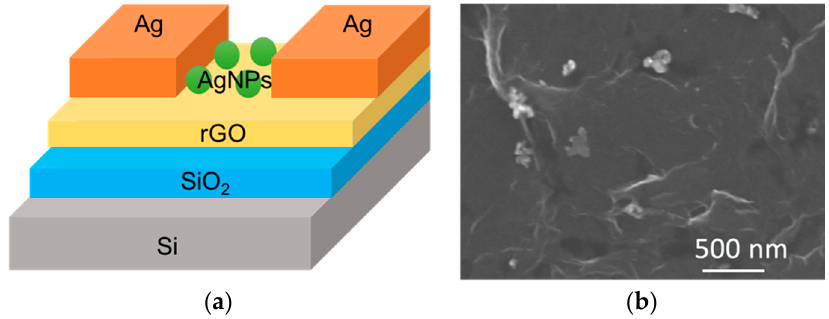
Figure 1. ( a ) Structure of a Ag nanoparticle-reduced graphene oxide (AgNPs-rGO) photosensor. The Ag nanoparticles mixed with reduced graphene oxide (rGO) were spin-coated on SiO 2 /Si to improve the performance of photosensors; ( b ) SEM image of rGO with 60–80 nm Ag nanoparticles (AgNPs).